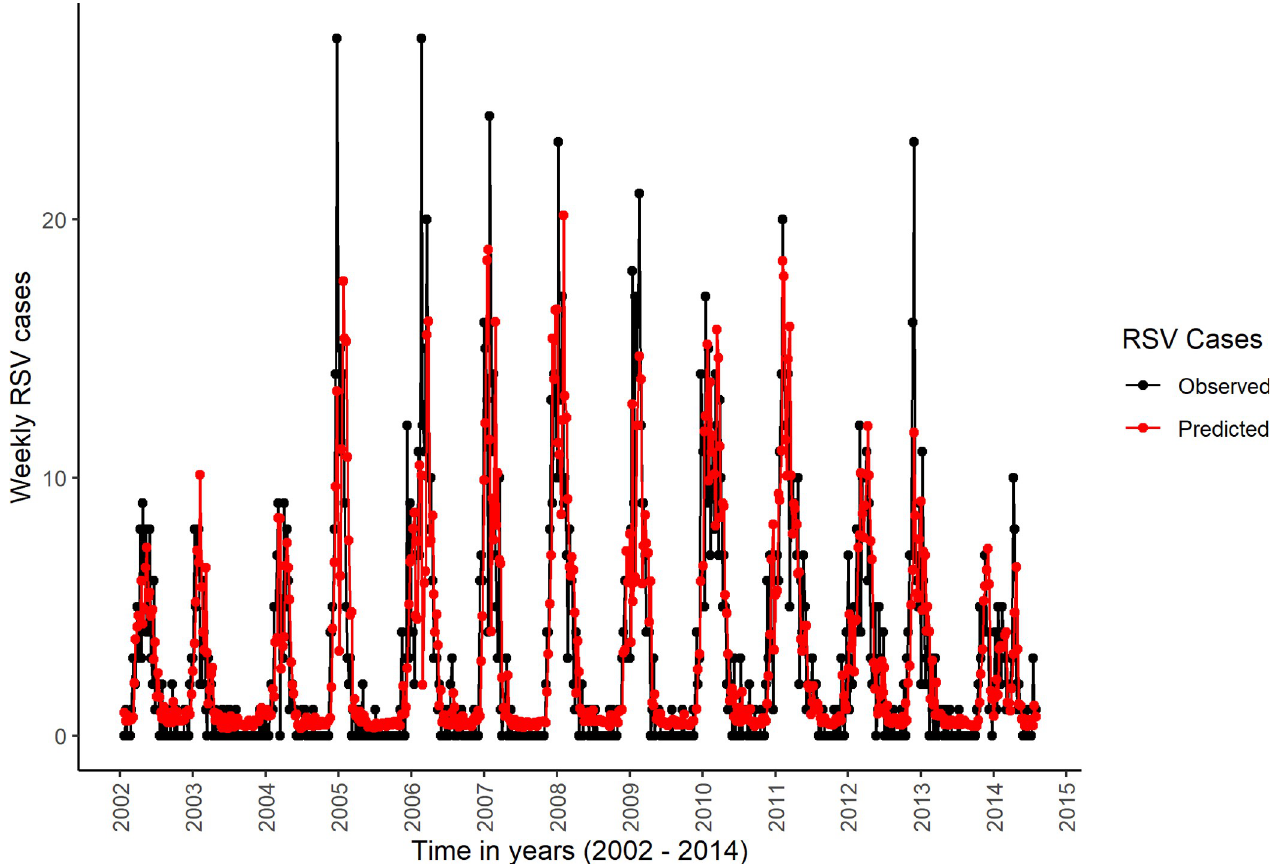
Fig 3. Plot of observed and predicted weekly RSV cases in the first imputed 2002–2014 dataset. The black line connects the observed weekly RSV cases while the red line connects the predicted weekly RSV